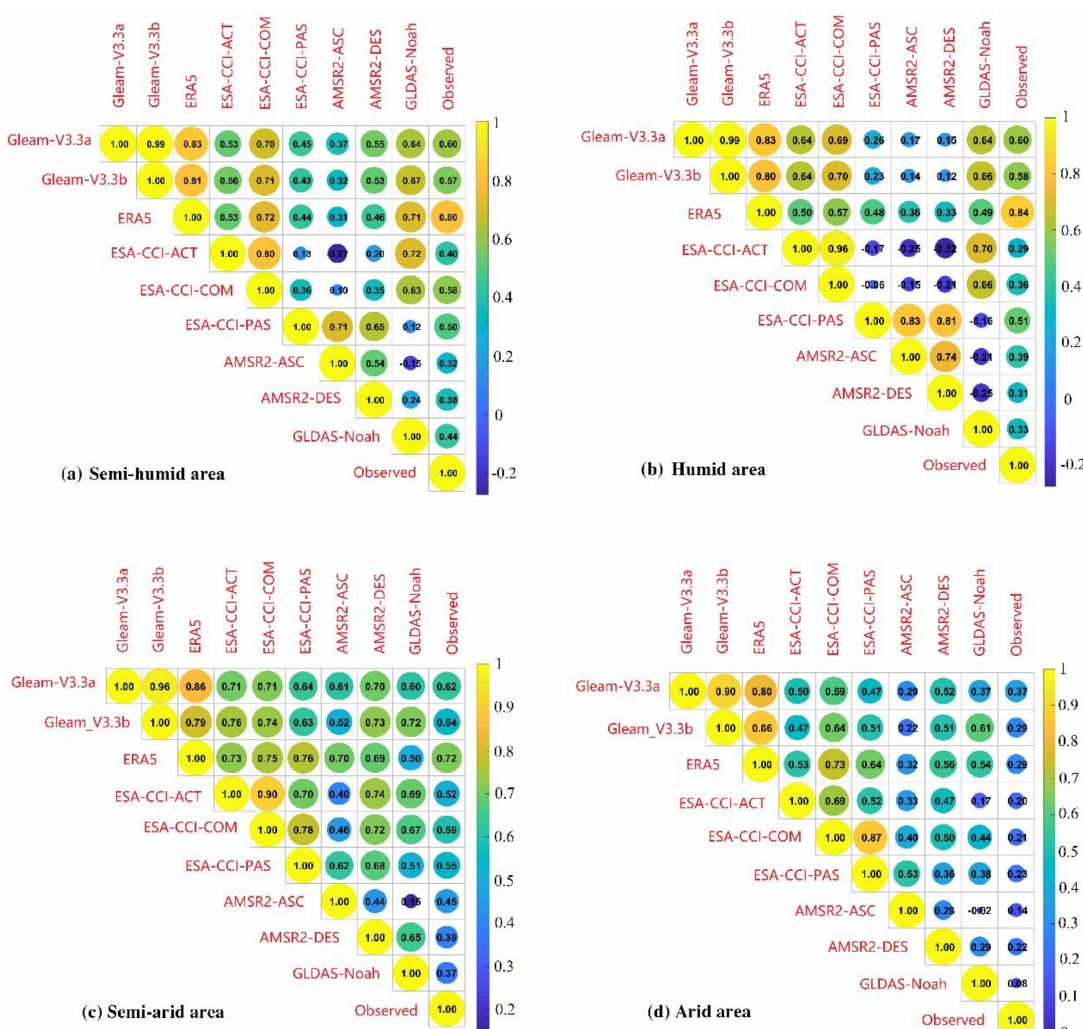
Figure 12. Pairwise CC of multi-source SM products in semi-humid ( a ), humid ( b ), semi-arid ( c ) and arid ( d ) areas.